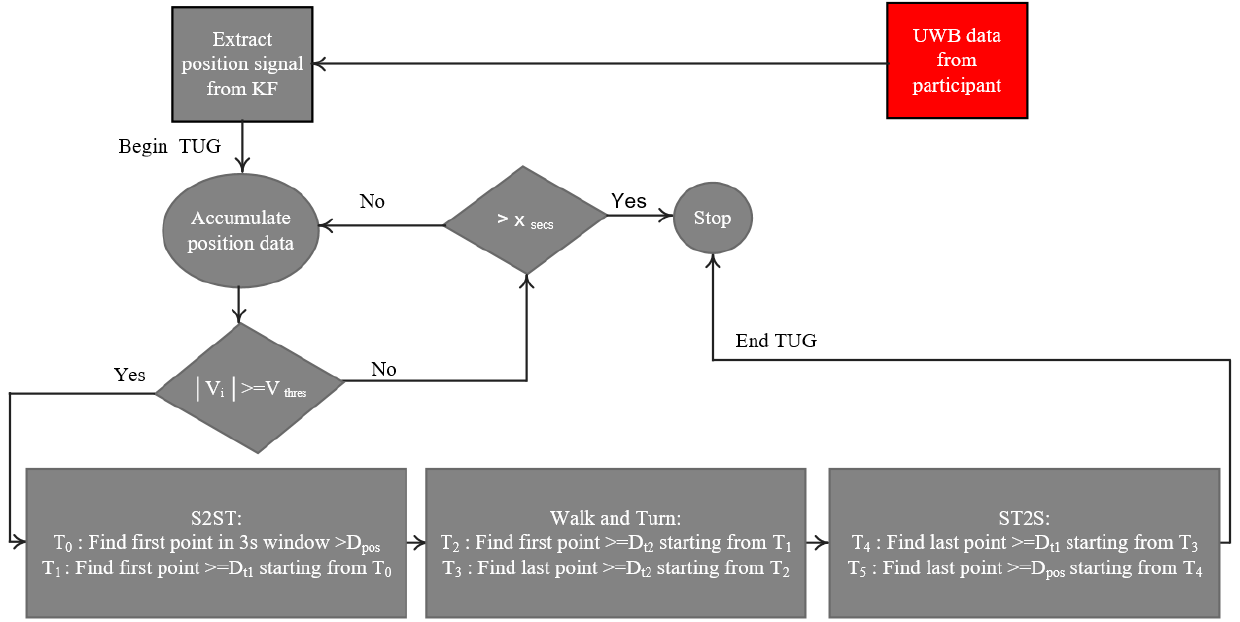
Figure 4. The flow diagram of the automated algorithm for segmenting TUG activities using the UWB radar signal. (D pos : the distance between the location of the radar and that of the chair; KF: Kalman filter; V i : is the instantaneous gait velocity; S2ST: Sit-to-stand; ST2S: Stand-to-sit; T i : different points detected for TUG segmentation; D ti : predefined distances during the TUG test).